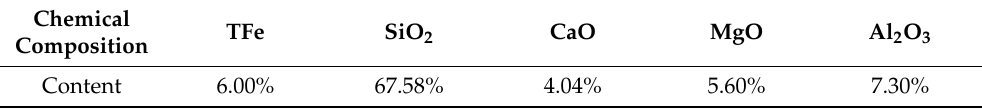
Table 3. Chemical composition and content of